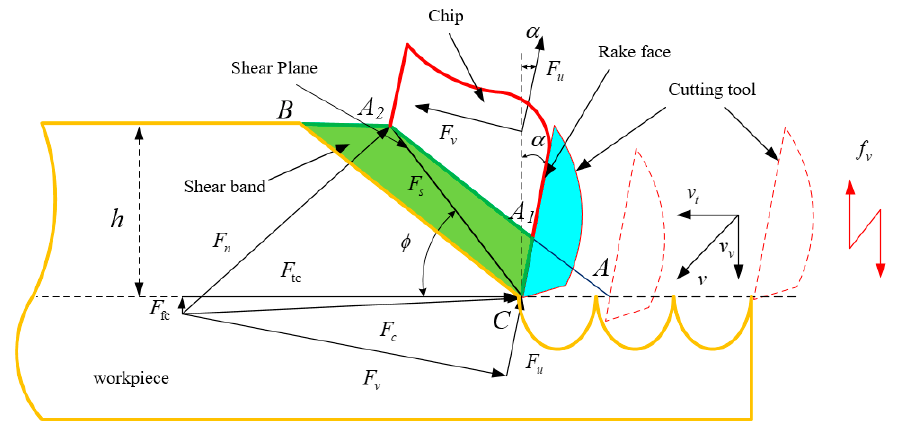
Figure 2. Principles of acoustic vibration-assisted cutting.